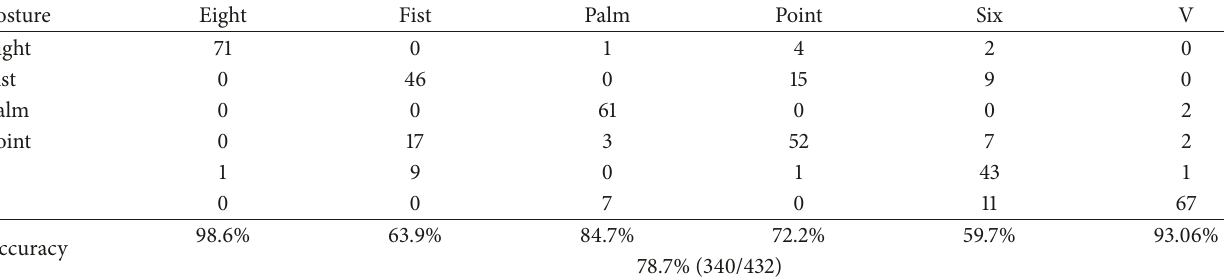
Figure 19: For each level of the octave, the original image is convolved with Gaussian in different variance. Adjacent Gaussian images are subtracted to produce the difference-of-Gaussian images. After each octave, the Gaussian image is downsampled by a factor of 2, and the process is repeated [22]. Table 8: Confusion matrix for posture recognition on the testing set.